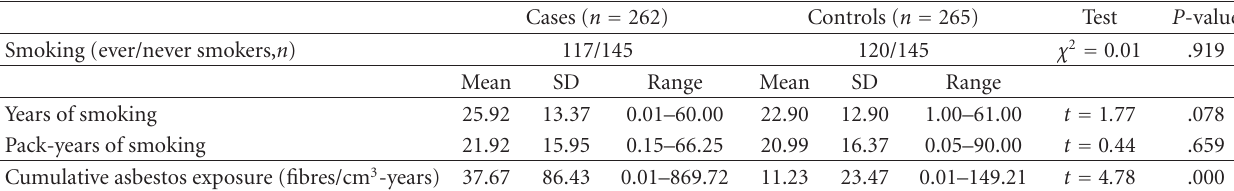
Table 1: Smoking and cumulative asbestos exposure in cases and controls.